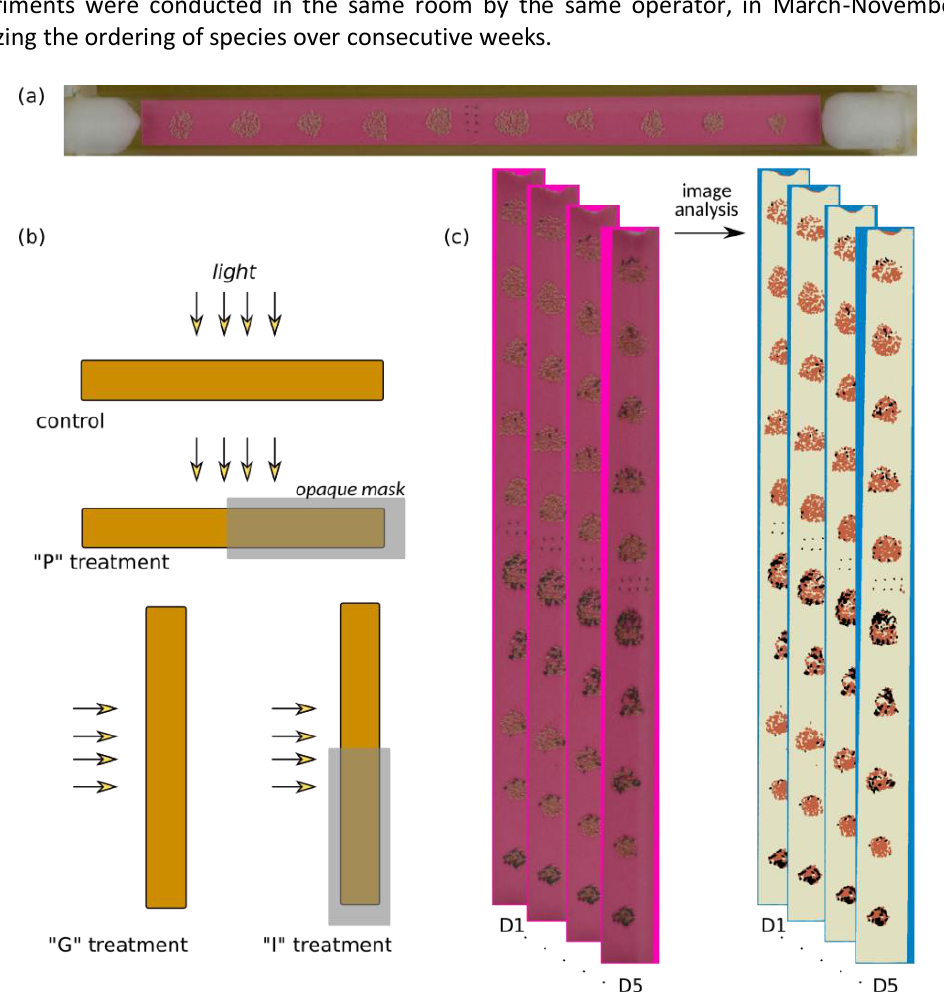
Figure 1. Experimental protocol and image analysis technique. (a) An experimental tube, containing 10 patches of host eggs, evenly spaced along its length. Eight ready-to-emerge Trichogramma individuals (dark eggs) are introduced in central position. (b) The four types of experiments conducted, differing